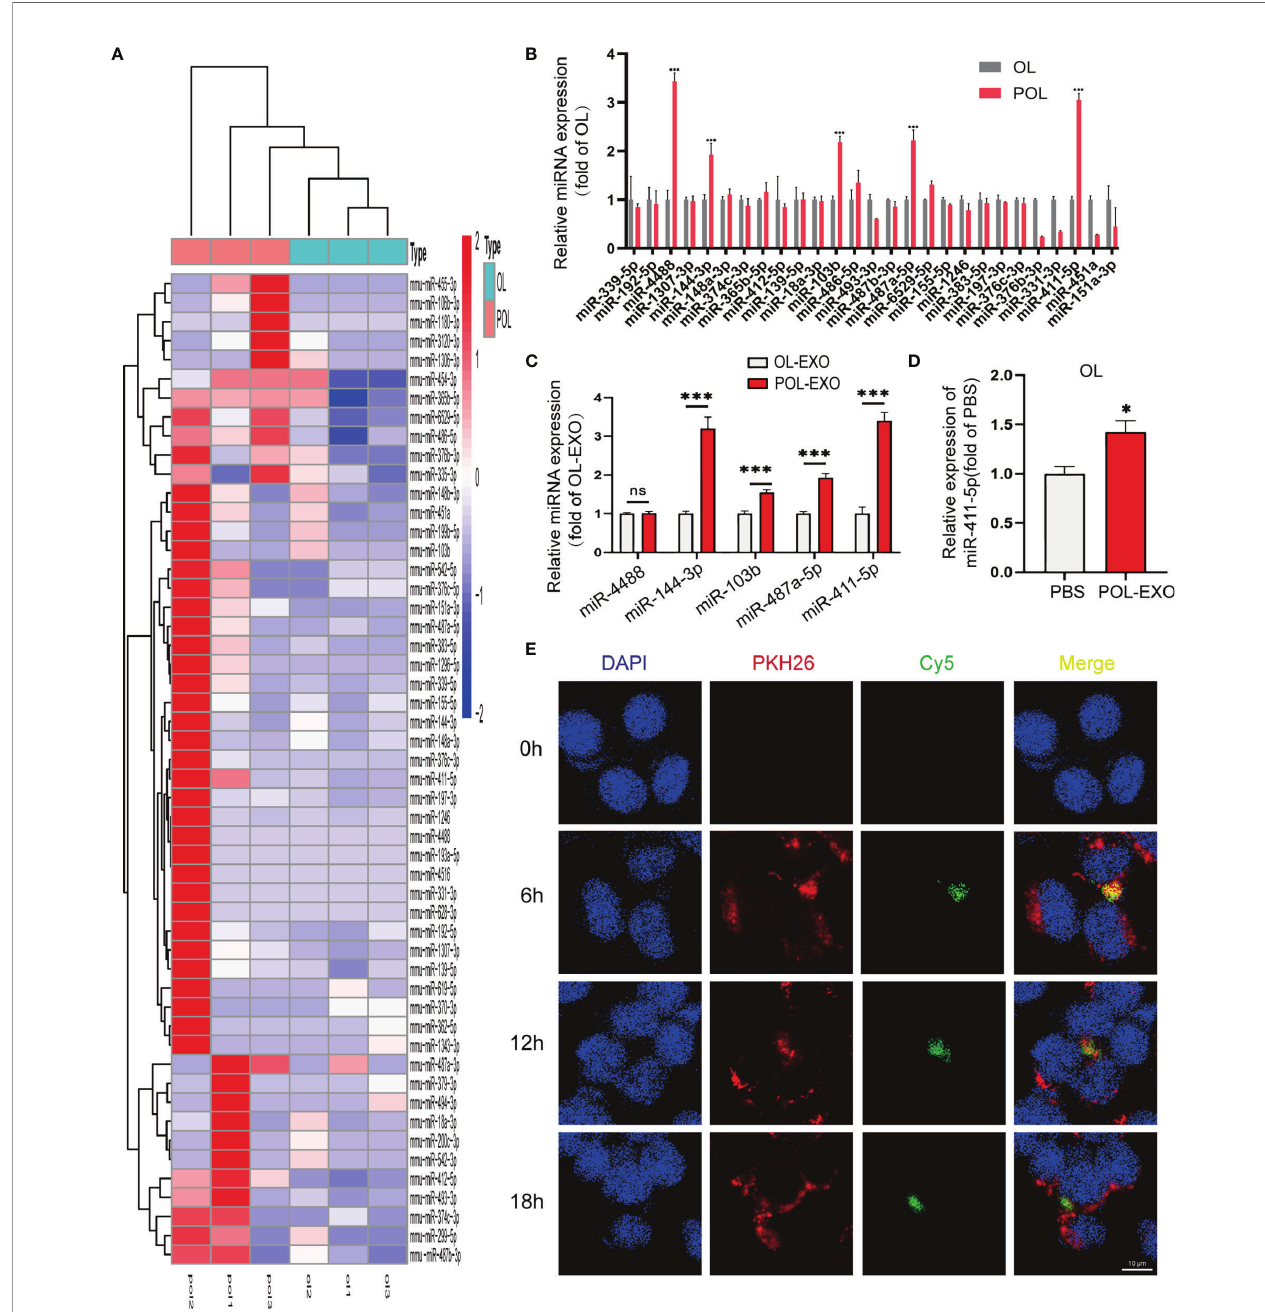
FIGURE 3 | miR-411-5p expression was signi fi cantly increased in POL and POL-EXO, and in OL cells upon up-taking of POL-EXO. (A) Heat map of miRNA expression pro fi le of POL-EXO and OL-EXO. (B) Validation of the expression of 27 up-regulated miRNAs in POL-EXO in OL and POL cells by qRT-PCR. The expression of miR-4488, miR-144-3p, miR-103b, miR-487a-5p and miR-411-5p was further validated in OL-EXO and POL-EXO by qRT-PCR (C) , ***p < 0.001). qRT-PCR was used to determine the expression of miR-411-5p in the OL upon co-culture with POL-EXO (D) , *p < 0.05). (E) Imaging analysis of the time course of OL uptake of exosomes secreted by POL-miR-411-5p-mimics cells, bar = 10 m m not signi fi